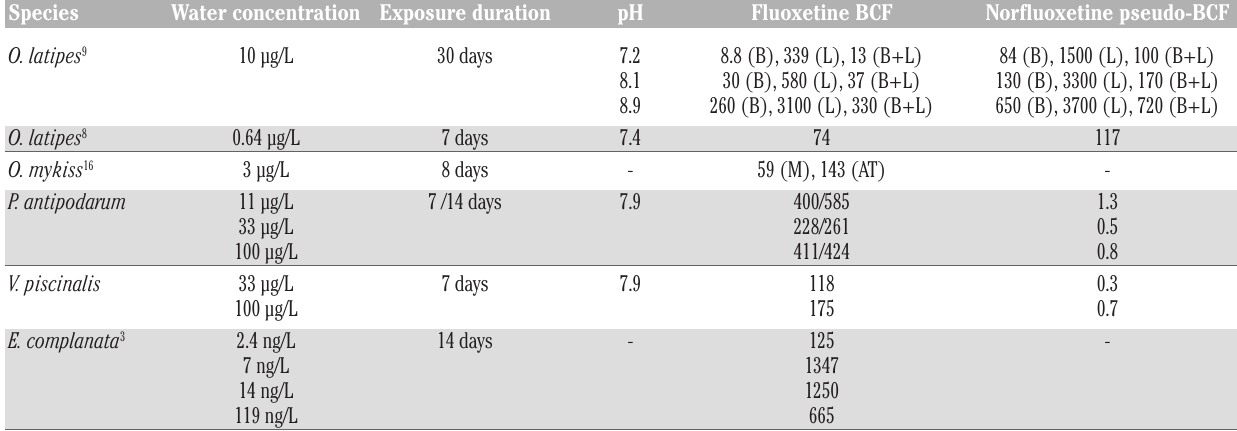
Table 2. Bioaccumulation factor (BCF) and pseudo-BCF in aquatic organisms.